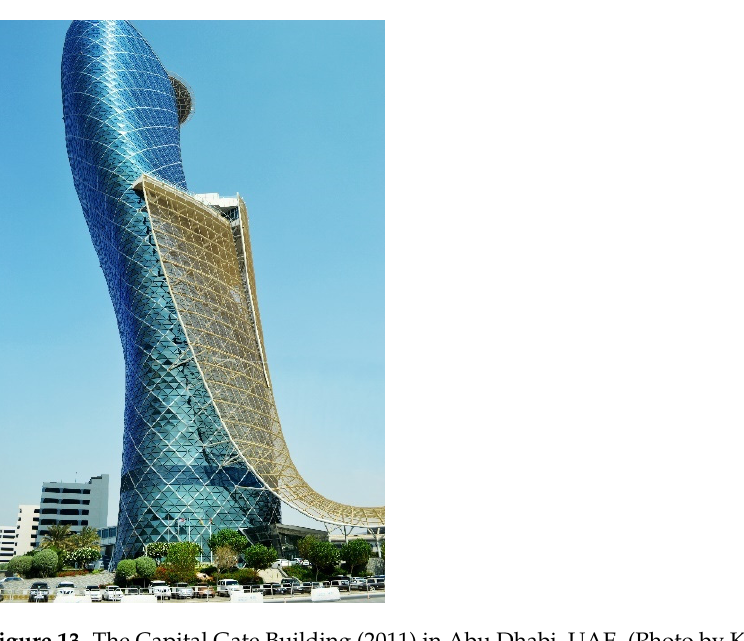
Figure 12. The Bow Tower (2012) in Calgary, Canada by Norman Foster. (Sketch by K. Al-Kodmany).